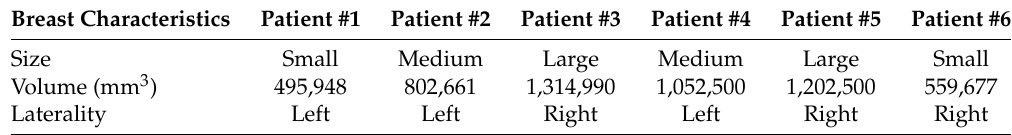
Figure 8. Sequential features combination used in dataset construction. Table 3. Characterization of breast MRI data used for data augmentation: size, volume and laterality. Breast